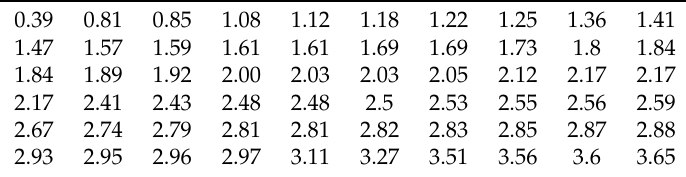
Table 13. Censored data with R = ( 1 ∗ 20,0 ∗ 20,1 ∗ 20 ) , T = 3.2, J = 55.